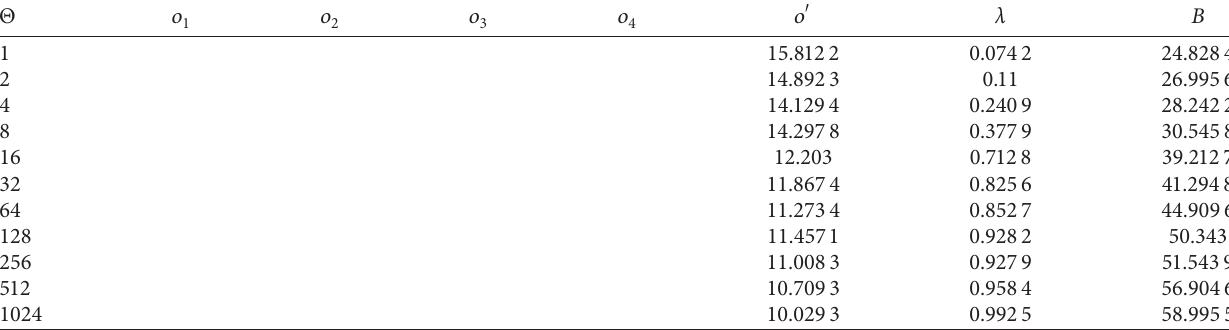
Table 4: Result of model (8).